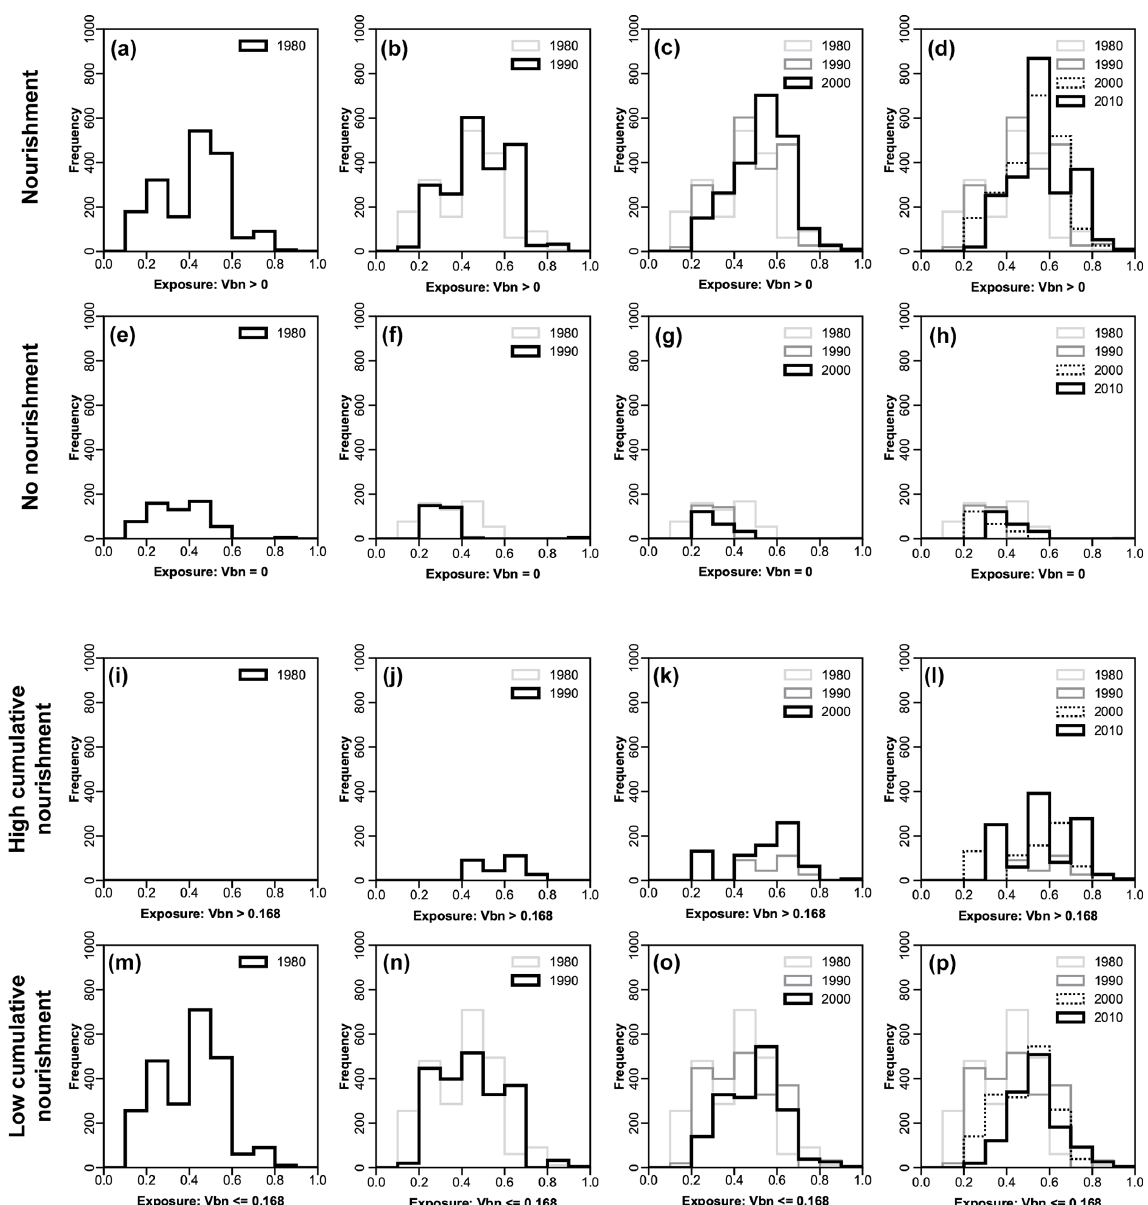
Figure 8. Transect-level distribution of exposure per coastal kilometre, by decade, (a–h) in counties that have and have not nourished, and (i– p) in counties that have nourished above and below the 2016 median cumulative beach-nourishment index ( V bn = 0 . 168). The 2016 median V bn denotes the normalized value of the overall median cumulative number of nourishments across the domain. Summary statistics for these distributions are provided in Table